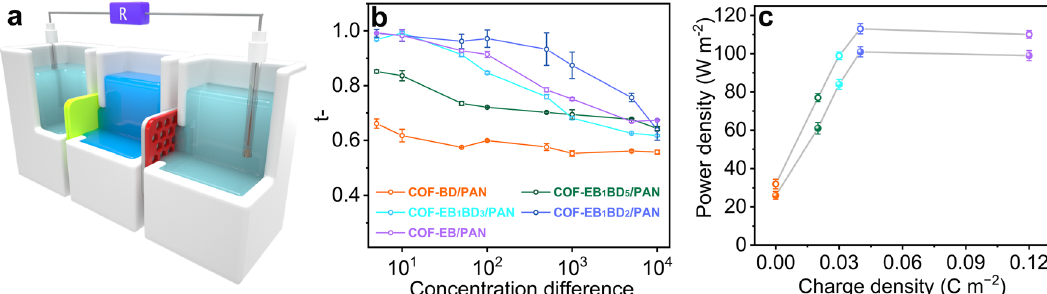
Fig. 3 Investigation of the impact of membrane charge density on the permselectivity and output power density. a Schematic of the experimental setup used to evaluate the permselectivity and output power density of the membranes with an effective working area of 0.0078 mm 2 . b Plots of t (cid:1) against differences in KCl concentration across COF-EB x BD y /PAN; the error bars represent the standard deviation of three independent measurements of the various membranes. c Plots of the maximum output power versus charge density obtained using a pair of RED stacks coupled with COF-EB x BD y /PAN and Na fi on ® 212, in which COF faced the high- (solid circles) and low-concentration sides (hollow circles), respectively (orange, COF-BD/PAN; olive, COF- EB 1 BD 5 /PAN; cyan, COF-EB 1 BD 3 /PAN; blue, COF-EB 1 BD 2 /PAN; violet, COF-EB/PAN). Error bars represent standard deviation of three different